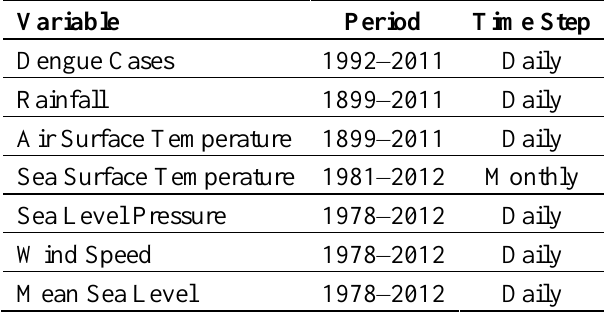
Table 1. Database and periods